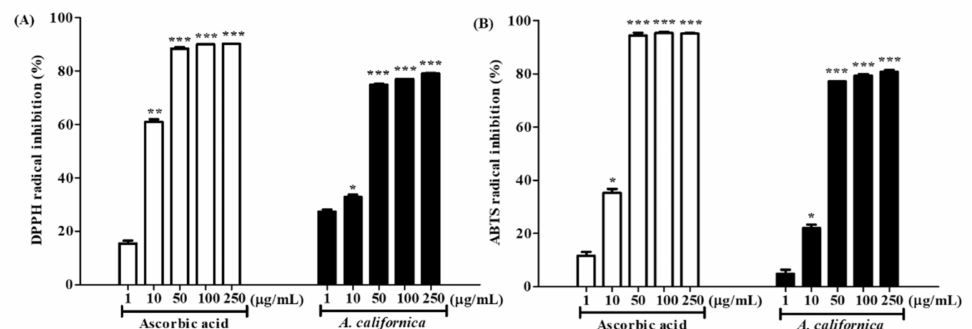
Figure 1. DPPH ( A ) and ABTS ( B ) inhibition of A. californica extract. The radical scavenging effect was presented as a percentage of that measured in the control group. Data are presented as the mean ± SD. *, **, and *** indicate the significant within-group differences (* p < 0.05 ** p < 0.01 and *** p < 0.001, respectively).